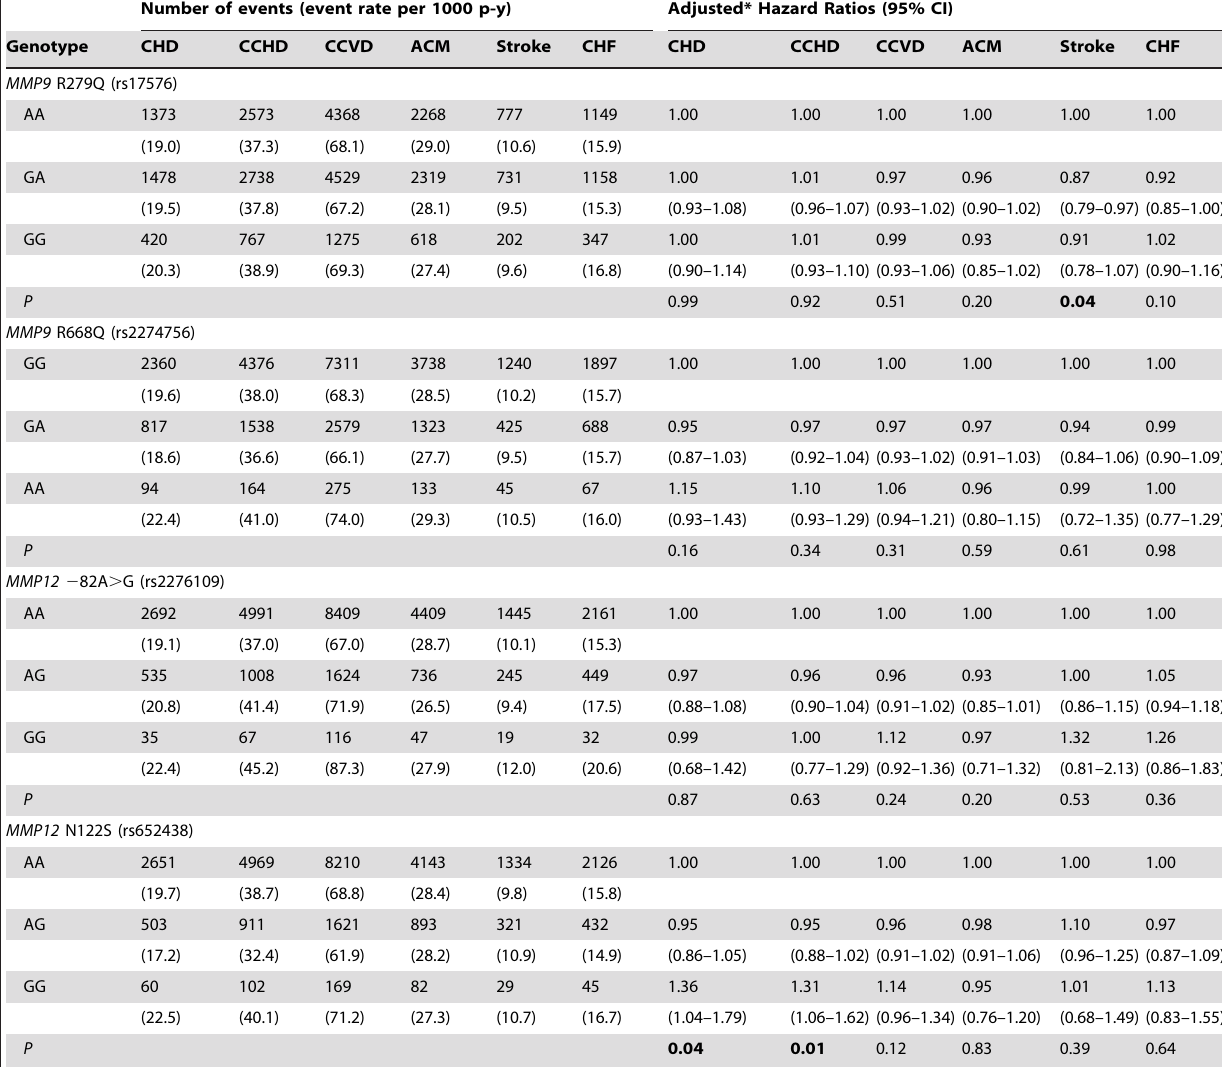
Number of events (event rate per 1000